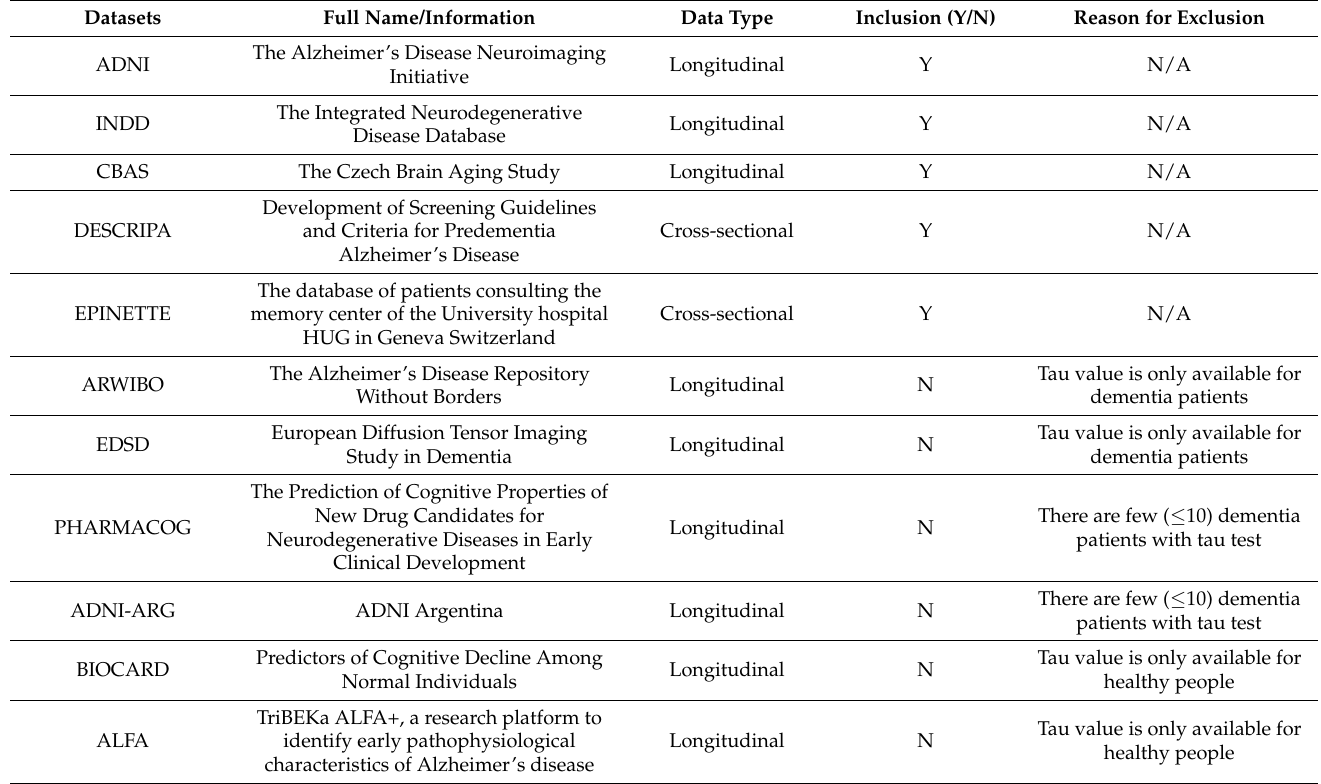
Table 1. The 11 preliminary datasets derived from the GAAIN database are listed. The ALFA and BIOCARD only included tau (total tau or phosphorylated tau) data for healthy people (MMSE > 24). On the contrary, there are tau data for only dementia patients in two datasets, ARWIBO and EDSD. In addition, there were few (10) dementia patients with tau tests in ADNI-ARG and PHARMACOG. Therefore, these six datasets were excluded from the